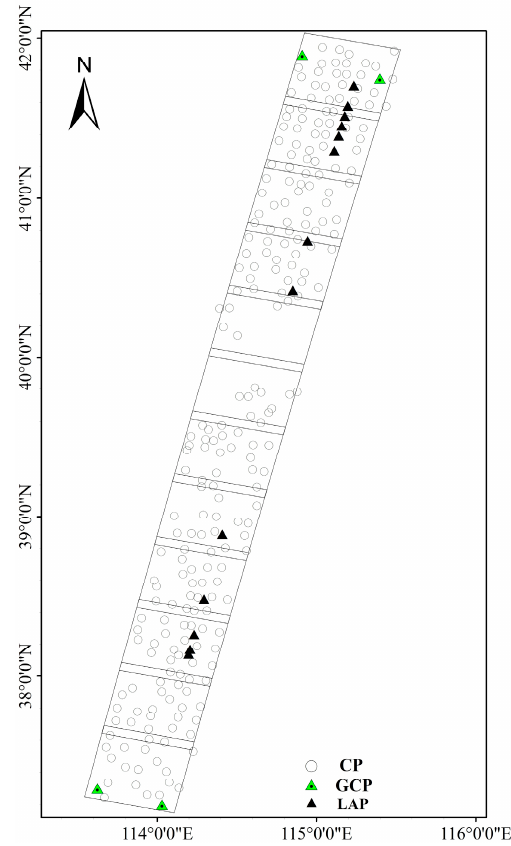
Figure 10. Schematic diagram of points’ distribution (CP, GCP, LAP, PCP) in Taihang research area.